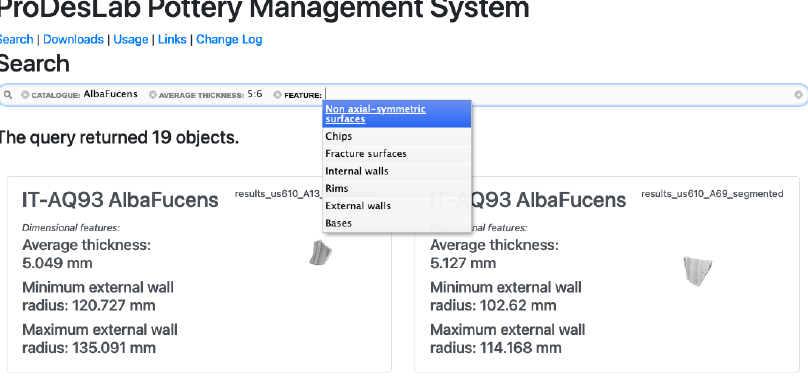
Figure 5. Web interface of search page.